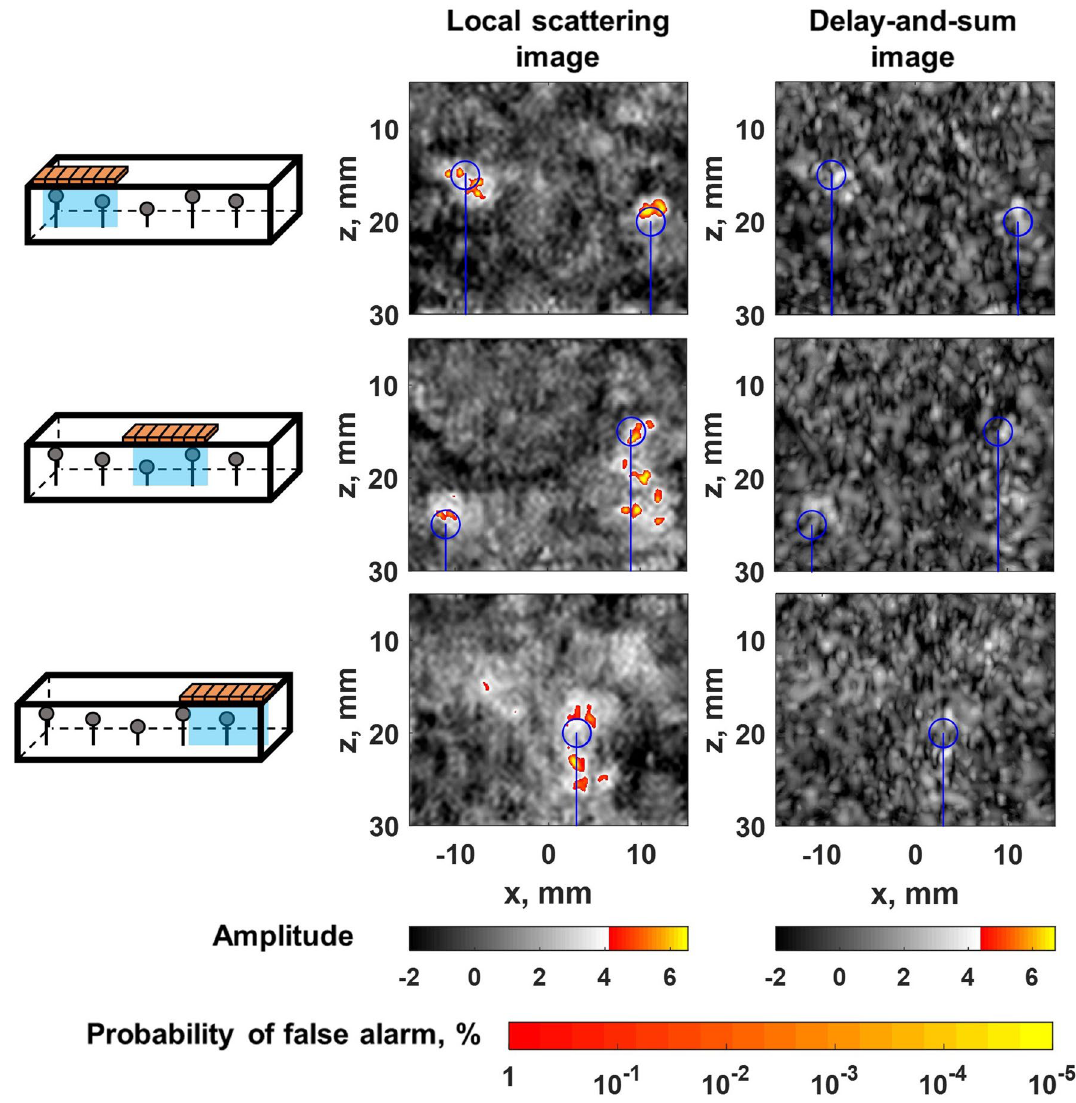
Figure 5. Experimental example of local scattering imaging: urethane-rubber sample. Examples of local scattering and delay-and-sum images of inclusions located at different depths inside the urethane-rubber sample. Blue circles indicate the nominal position of inclusions. The global false alarm rate is shown as the second